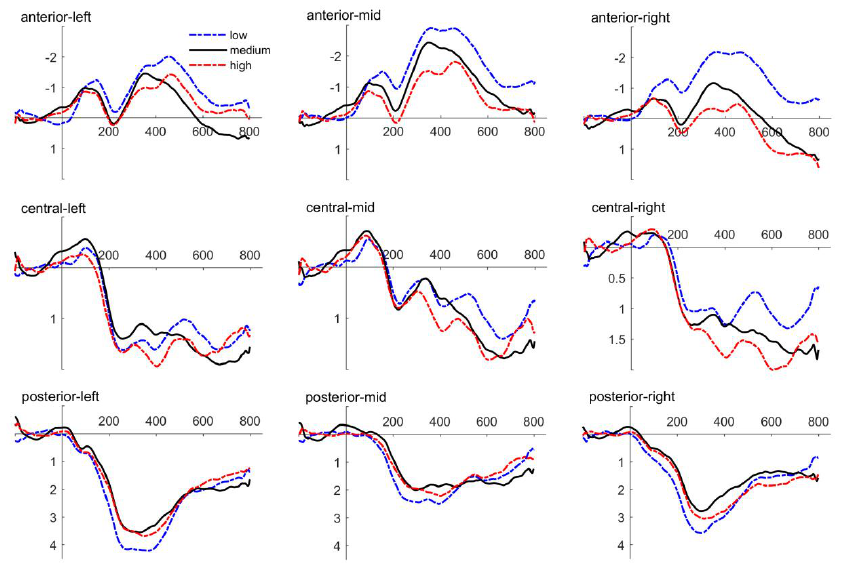
Figure 7. Grand average ERPs plotted for the high-cure rate condition. 3.2.1. N1 The results of the rmANOVA showed a significant main effect of risk probability, F (2, 52) = 3.864, p = 0.027, η p2 = 0.129. The medium-risk probability elicited larger N1 am- plitudes than the low-risk probability, p = 0.03, and then the high-risk probability, p = 0.02. There was no difference between the low and the high-risk probability, p = 0.70. Moreover, there were no significant main effects or interactions with risk probability and cure rate or interactions of topographic factors with at least one experimental factor in these nine clusters, all p s > 0.159.